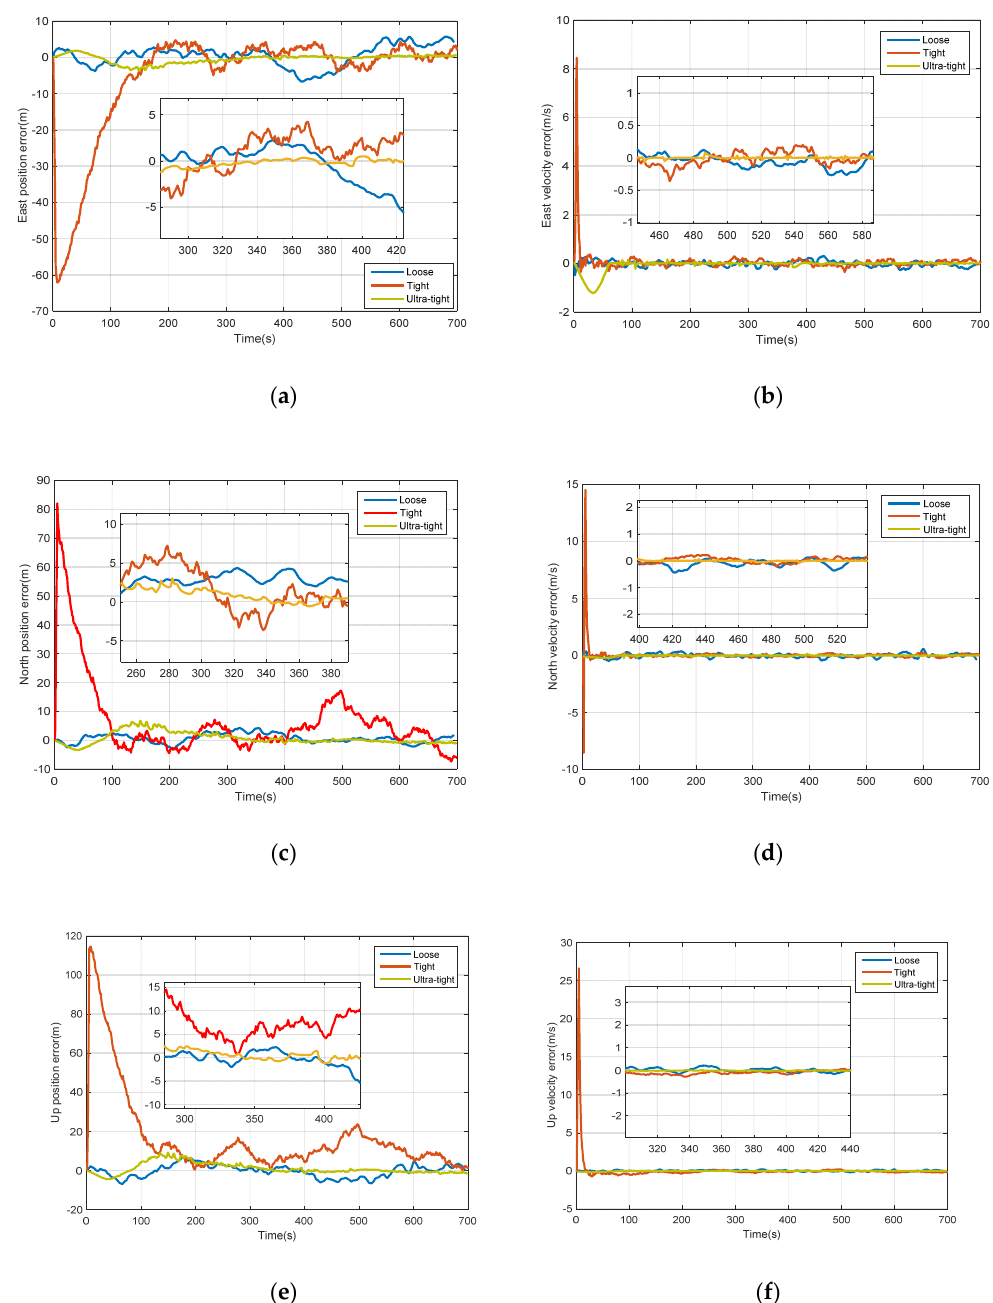
Figure 10. Comparison with loose and tight integration systems. ( a ) Position errors in east; ( b ) velocity errors in east; ( c ) position errors in north; ( d ) velocity errors in north; ( e ) position errors in up; ( f ) velocity errors in up.